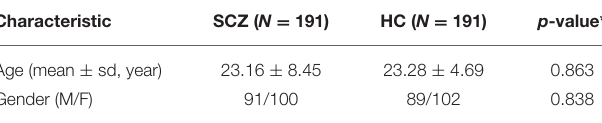
TABLE 1 | Participant demographics.